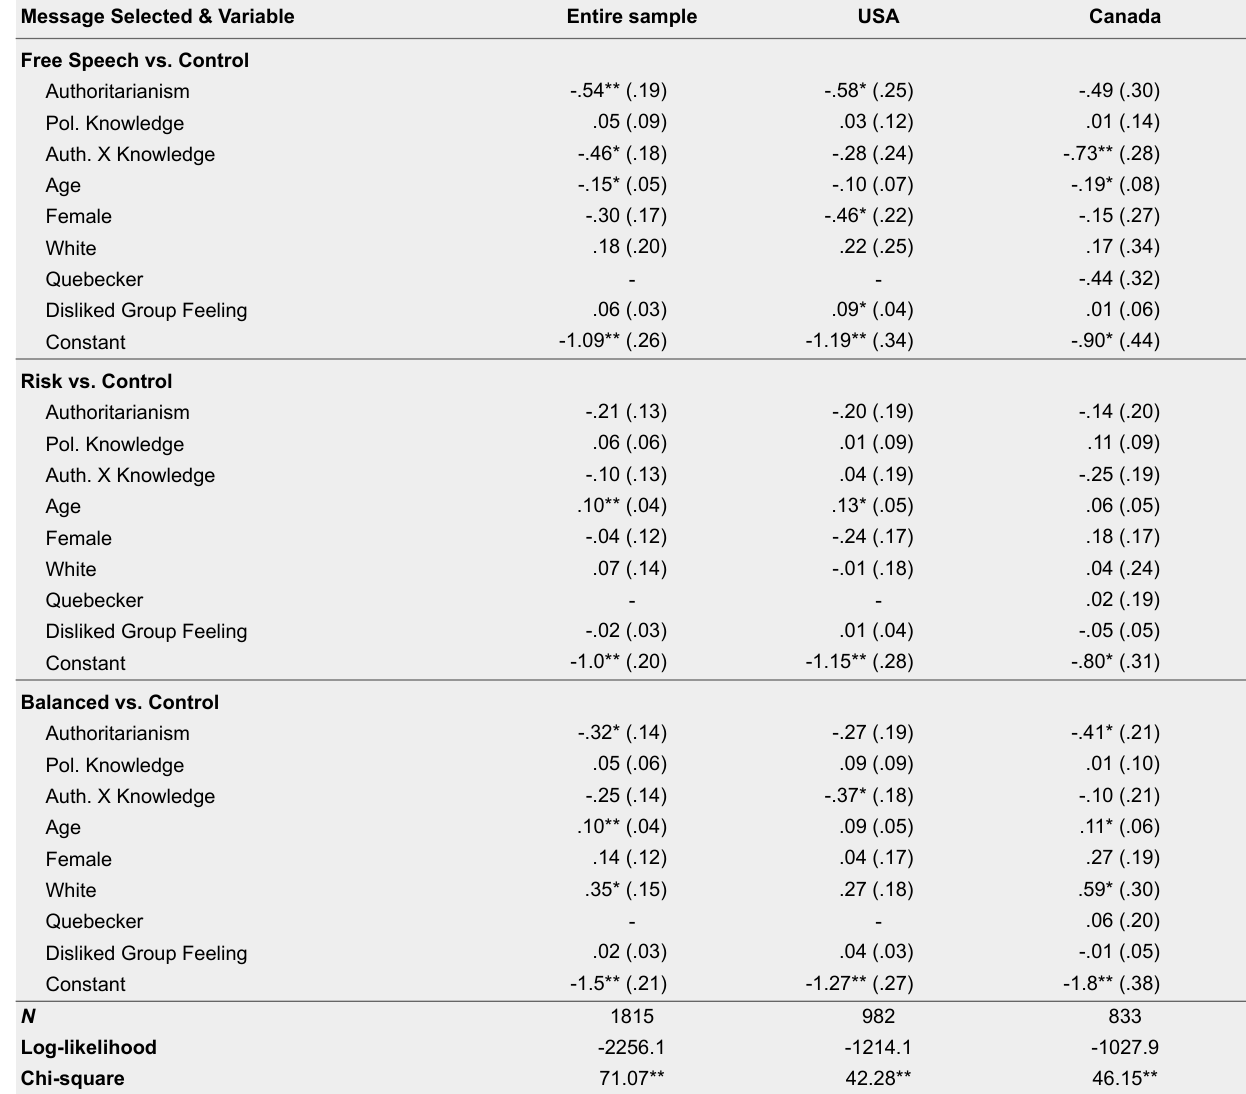
Multinominal Logistic Regression: Predictors of Message